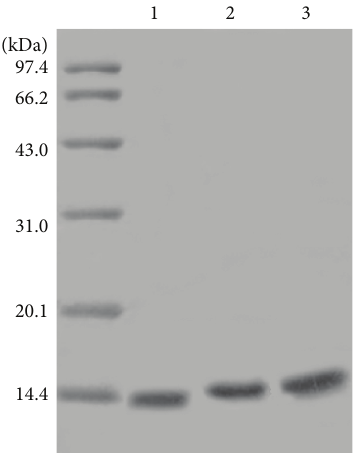
Figure 1: SDS-PAGE of zinc finger proteins. Lane 1: ZNF191(243- 368), lane 2: His 6 -ZNF191(243-368), and lane 3: ZNF191(243-368)- His 8 .